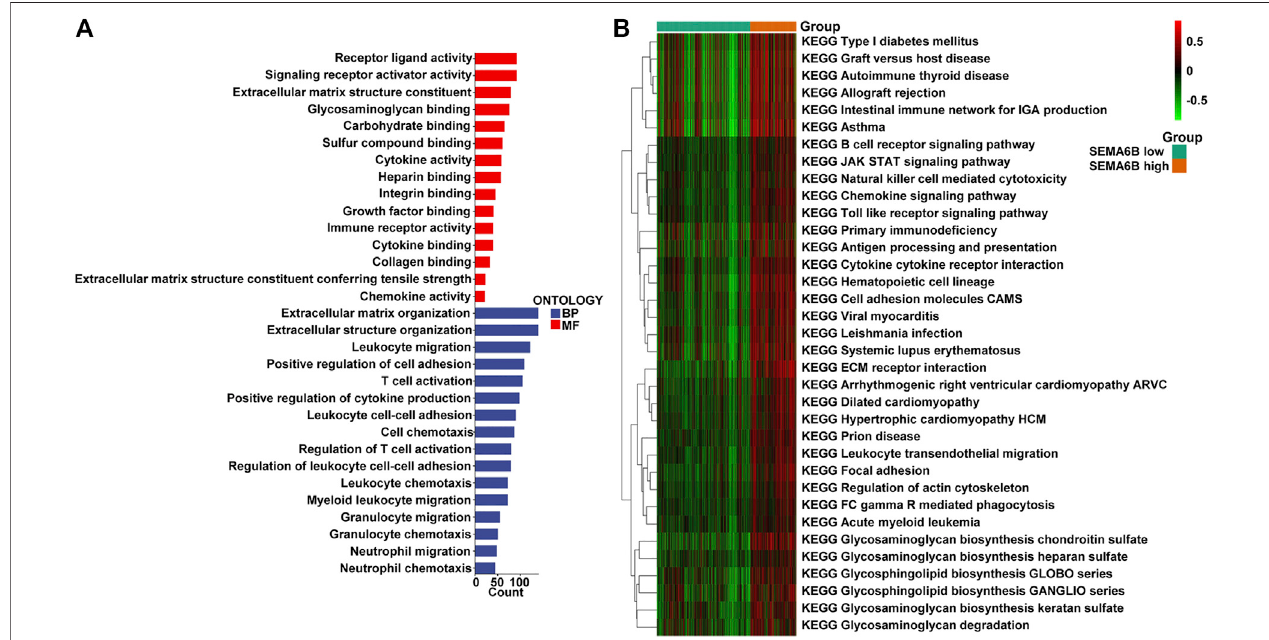
FIGURE 7 | GO and GSVA enrichment analysis. (A) The 15-most signi fi cantly enriched GO terms in terms of upregulated mRNAs in the high SEMA6B expression group are listed according to their biological processes (BP) and molecular functions (MF). The length of each bar indicates the number of enriched genes. (B) The heatmap was used to visualize the result of GSVA enrichment analysis in high and low SEMA6B expression groups. The color changes from green to red, indicating an increase in the value of the enriched score. Brown represents the high SEMA6B group and green represents the low SEMA6B group.